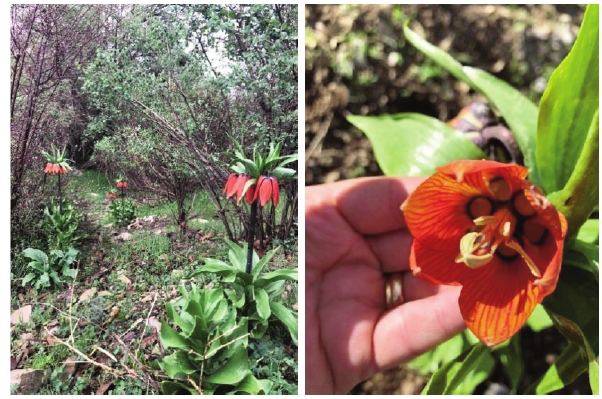
Fig. 1 ­ Fritillaria imperialis L. growing at its natural habitat (mountain regions and Zagros altitudes, Ilam province,